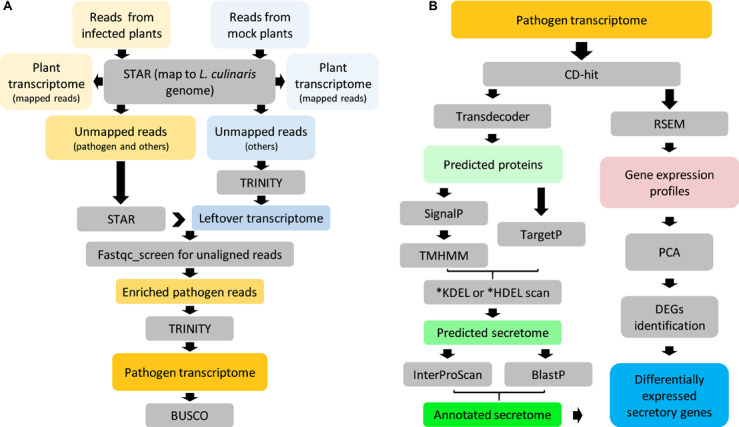
Overview of Ascochyta lentis sequencing data analysis. (A) Enrichment of A. lentis reads from mixed reads for de novo transcriptome assembly. (B) Prediction, annotation and expression profile of A. lentis secretome.